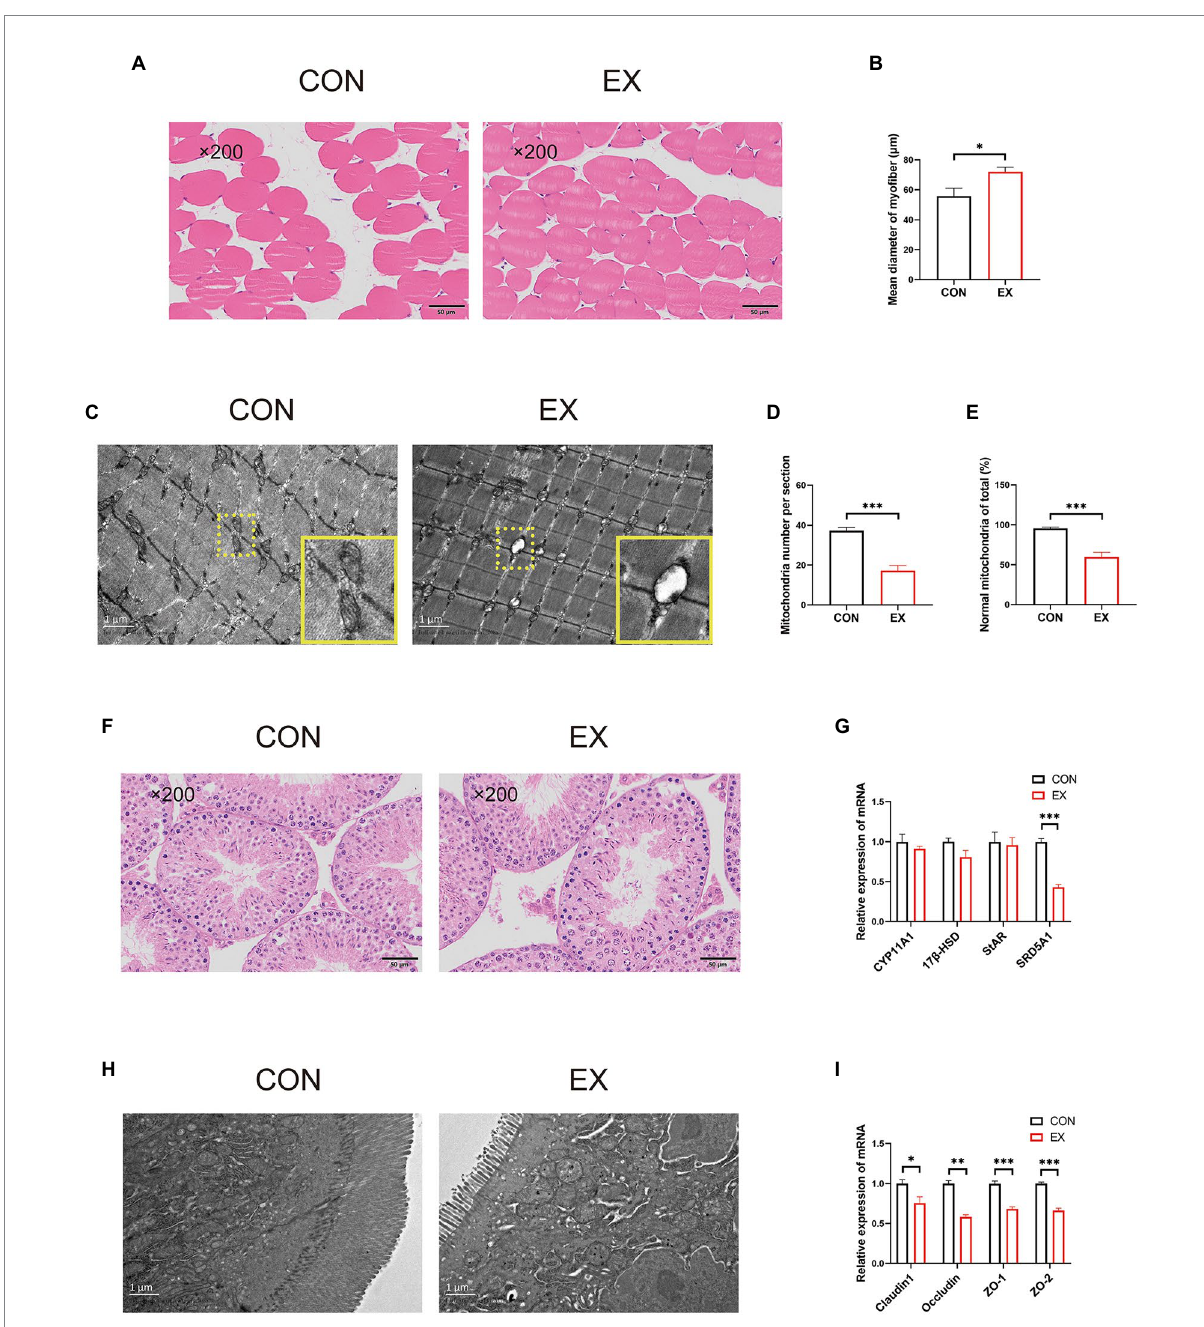
FIGURE 2 High-intensity aerobic exercise improved the CSA of the skeletal muscle (CON vs. EX). (A) HE staining of the skeletal muscle. (B) Mean diameter of the myofiber. (C–E) Mitochondria oxidative stress damage to skeletal muscle through transmission electron microscopy. (F) HE staining of the testis. (G) The expression of StAR, CYP11A,17 β -HSD, and SRD5A1 by qPCR. (H) Transmission electron microscopy of the small intestine. (I) The expression of Claudin1, Occludin, ZO-1, and ZO-2 by qPCR ( ∗ p < 0.05; ∗∗ p < 0.01; ∗∗∗ p <